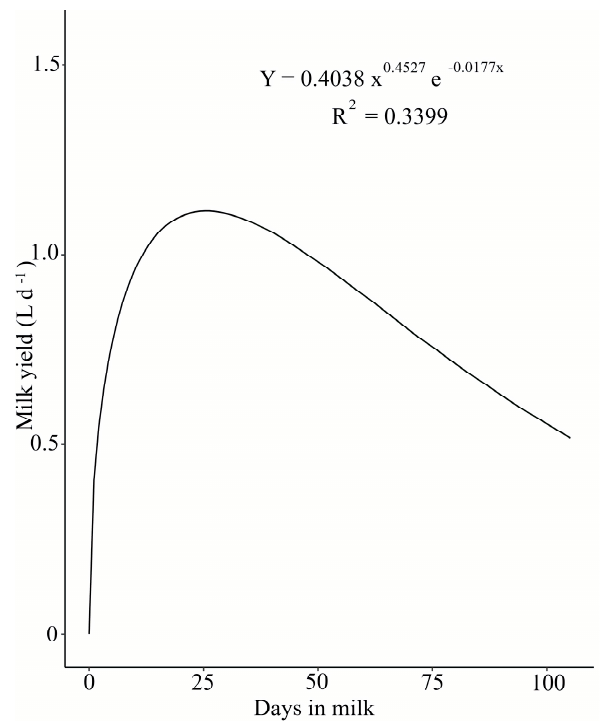
Figure 1. Milk yield (L day − 1 ) of Araucana creole ewes ( n = 20), during days 1–90 of lactation, predicted by Wood’s equation [23].